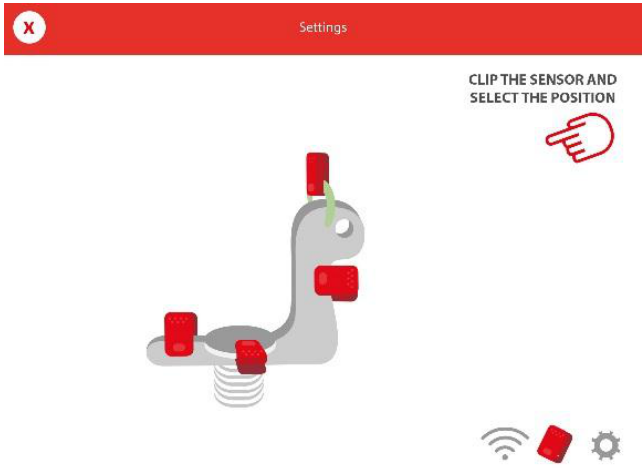
Figure 9. Instructions to perform the calibration of the sensor with regards to the element of the playground.